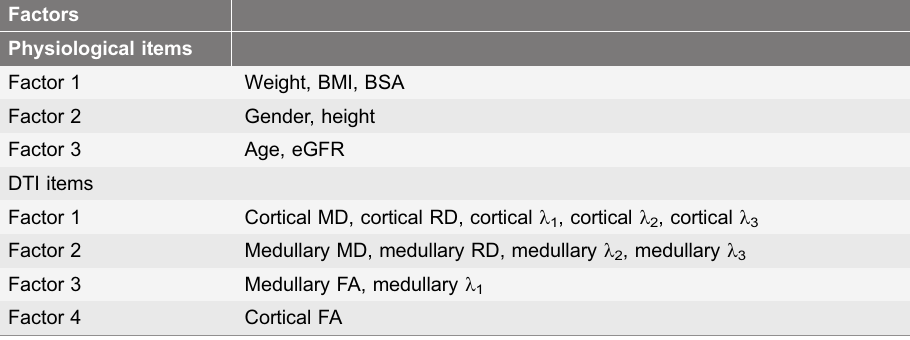
Table 7. Extracted factors from tested